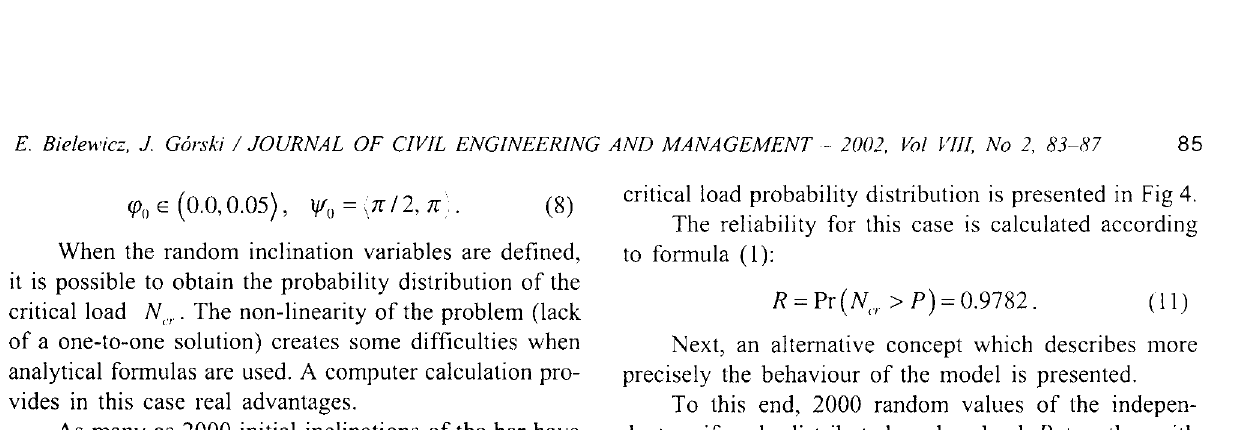
Fig 5. Case I a: histogram of the limit state